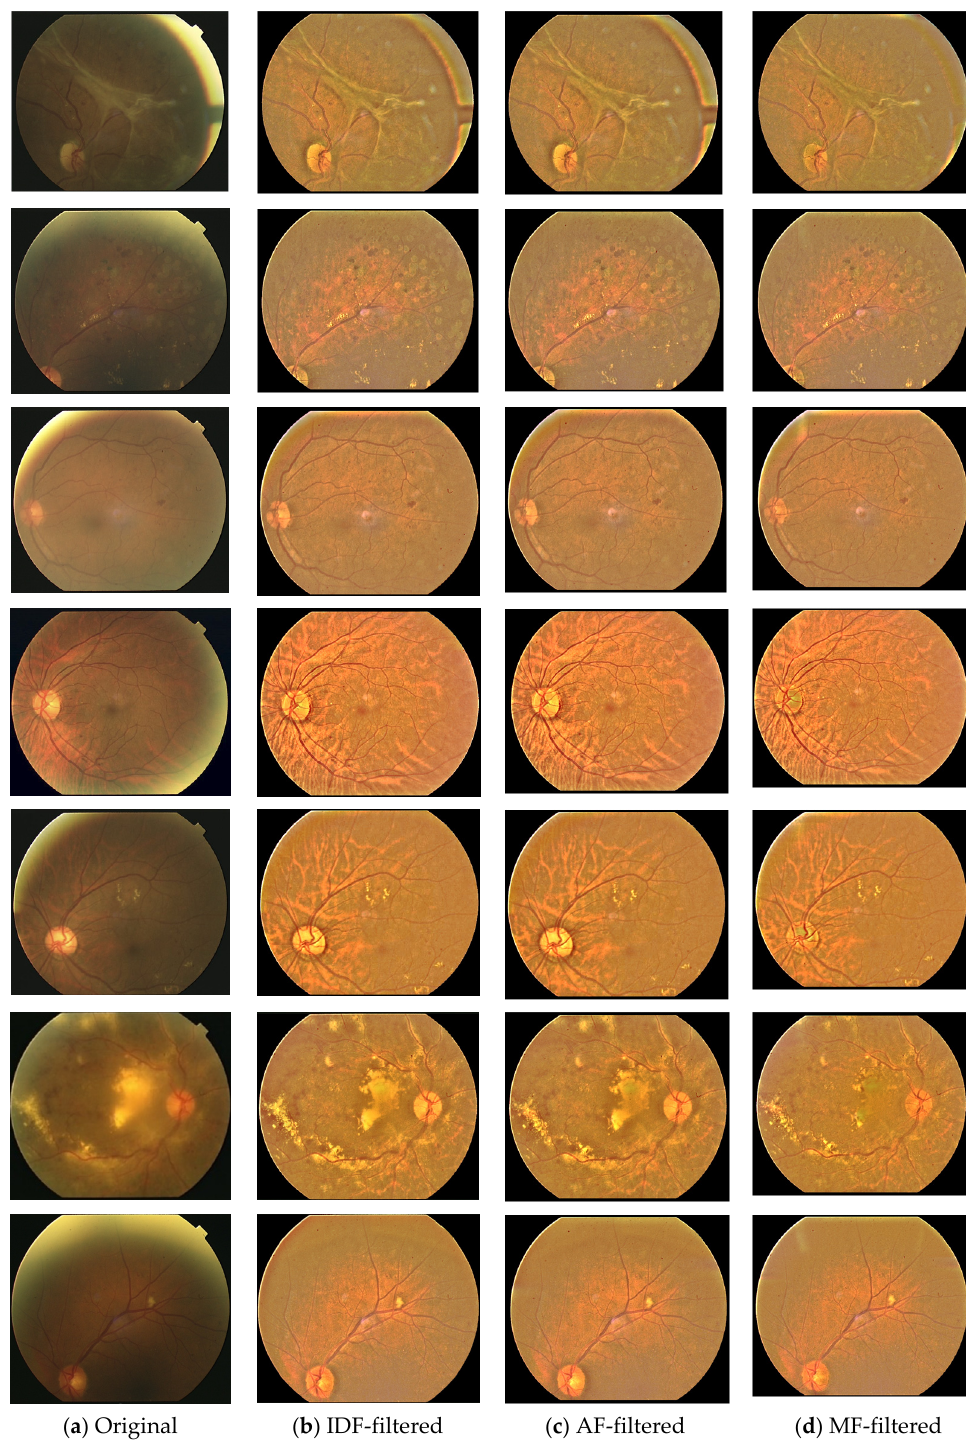
Figure 6. Seven samples of fundus images that were selected randomly and improved using the three filters. three